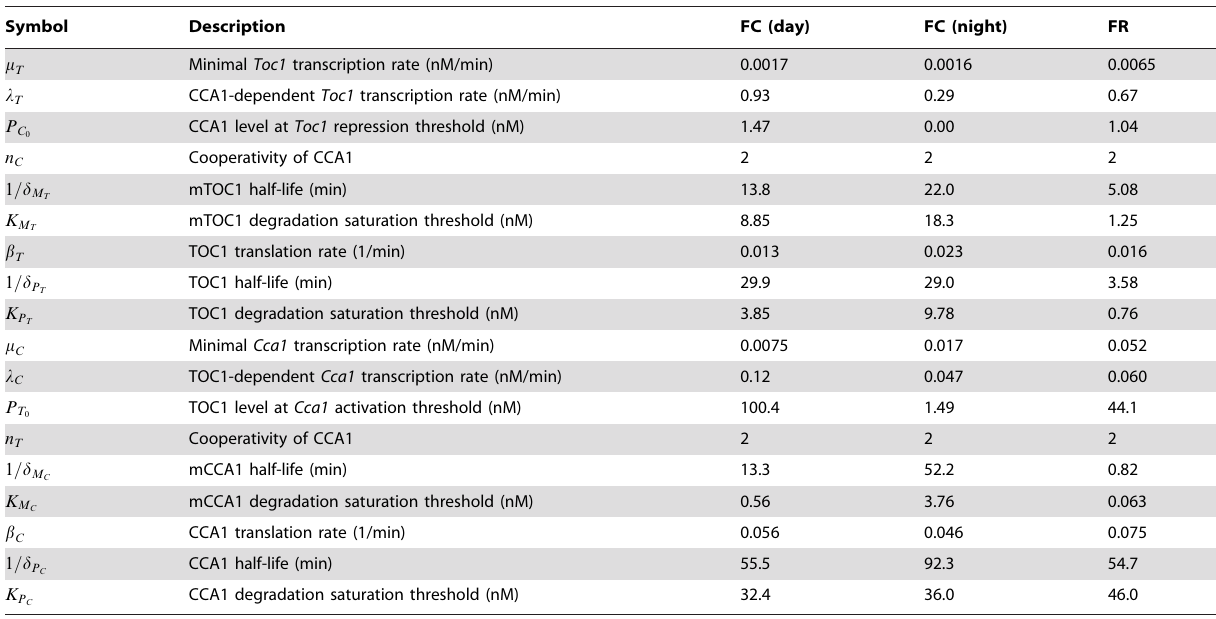
Table 1. Model parameter values.